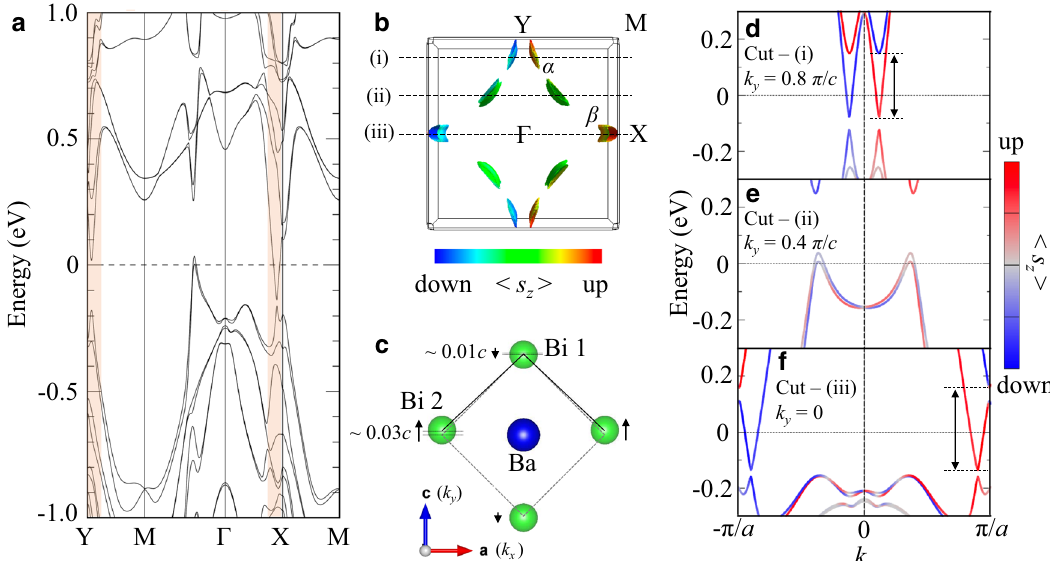
Fig. 2 Band structures and spin-polarized Fermi surfaces. a Calculated band structure of BaMnBi 2 with SOC. b Spin-resolved Fermi surfaces calculated at − layer deduced ϵ = 0 eV. The color of Fermi surfaces represents the spin polarization < s F z > . c Atomic displacements (denoted by arrows) within the Bi from the structural analysis. Owing to the lattice distortion, the black solid lines connecting the centers of Bi1 and Bi2 deviate from the gray dotted lines that describe a square centered at Ba. d-f Energy dispersion cuts along the dashed lines (i) – (iii) shown in b . The red and blue colors represent spin up and down, respectively. Vertical double-headed arrows in d and f denote the spin splitting